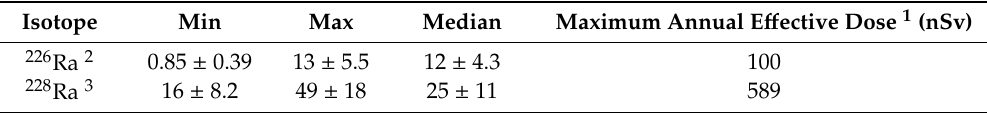
Table 5. Activity concentrations for radium measured in bottled water (mBq / L).